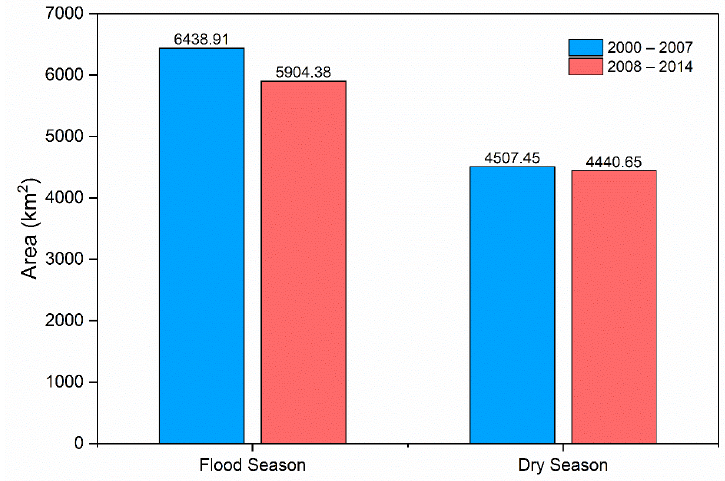
Figure 3. Comparison of the Intra-annual Area Variation of Tonle Sap Lake before and after 2008.